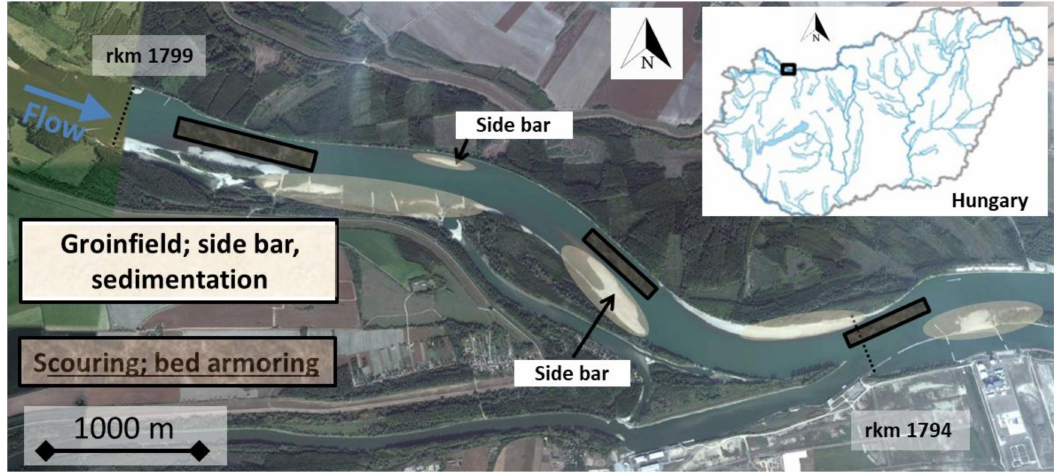
Figure 1. The sketch of the investigated section of the Danube